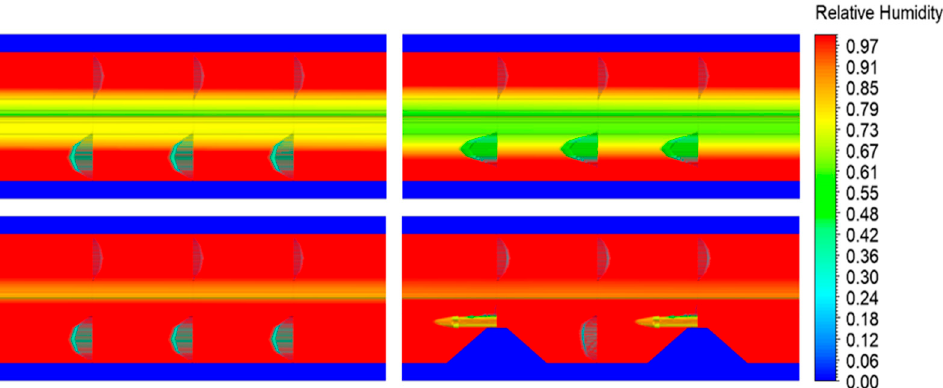
Figure 5. Relative humidity contours: conventional rectangular channels ( above left ); biporous cathode channel ( above right ); porous cathode channel ( below left ); porous and baffled cathode channel ( below right ) at operating current density of 4.0 A·cm − 2 .